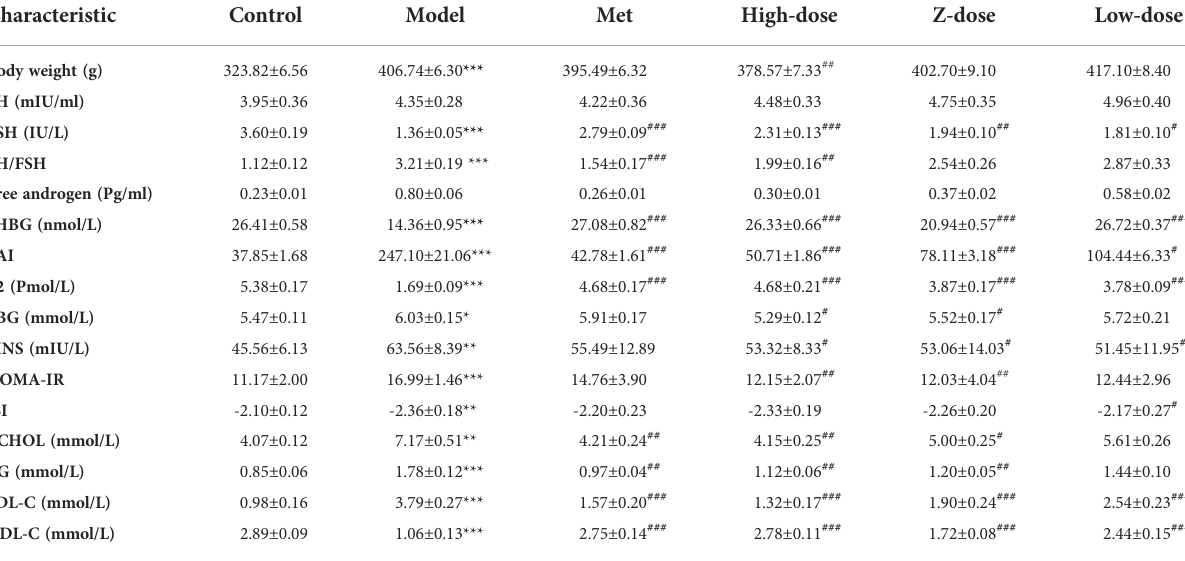
TABLE 2 Body weight and serum